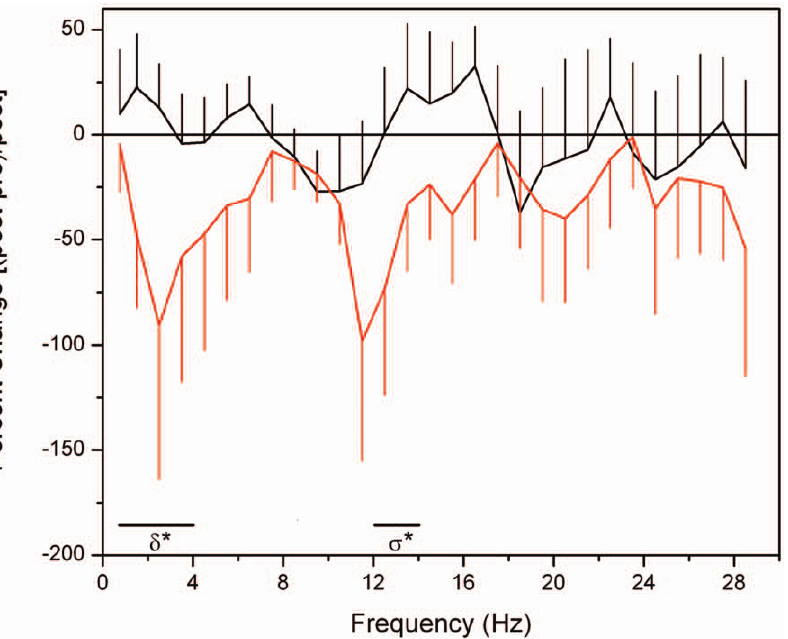
Figure 3. Change in EEG power in response to flash or dark stimuli. Percentage change in EEG power from before to after the dark (black) or flash (red) stimuli are presented. Significant (*p , 0.05) differences between conditions are found in the delta ( d ) and sigma ( s ) bands.